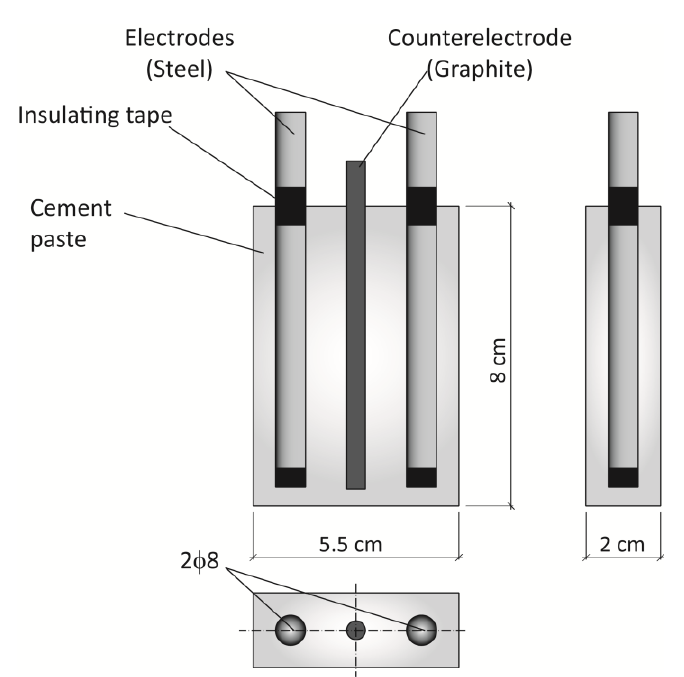
Figure 5. Dimensions of the specimens for corrosion